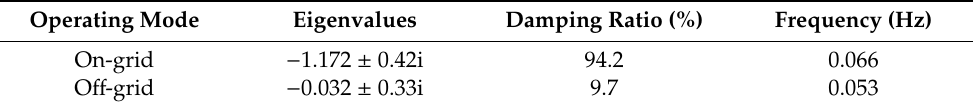
Table 7. Ultralow-frequency oscillations under di ff erent operating